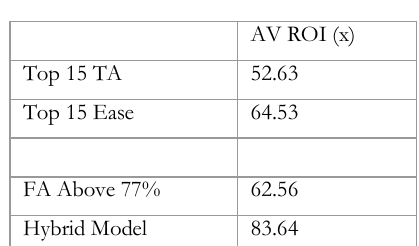
Table 4. Average ROI